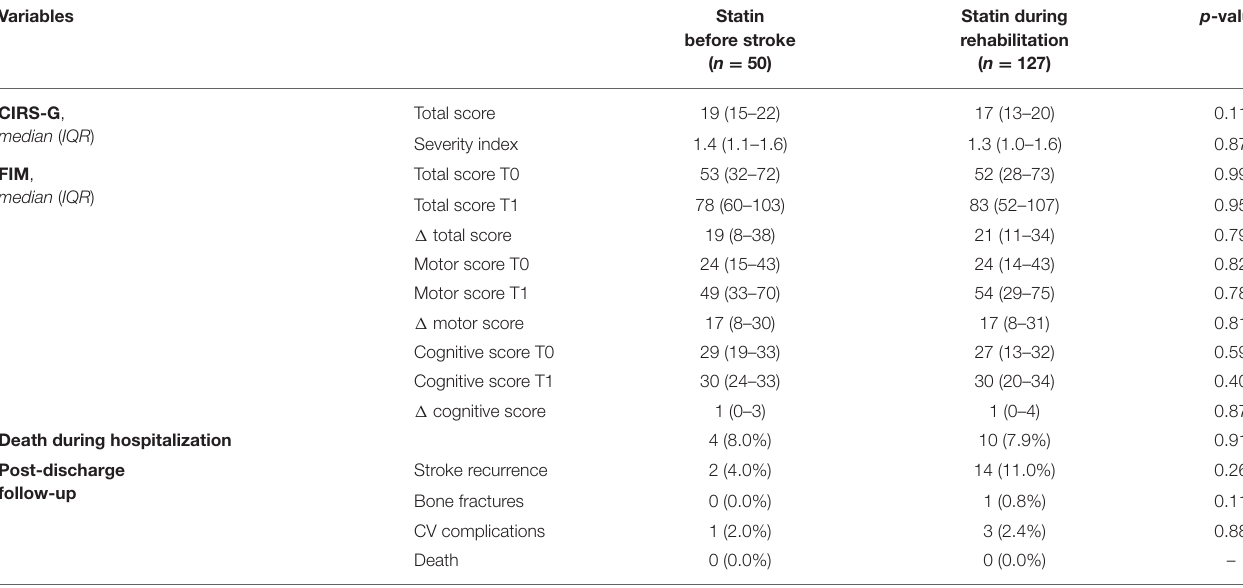
TABLE 2 | Rehabilitative and follow-up characteristics of patients treated with statin subdivided into two groups according to the beginning of treatment: patients who started statin therapy before stroke even and patients who started treatment at the beginning of rehabilitation process. Variables